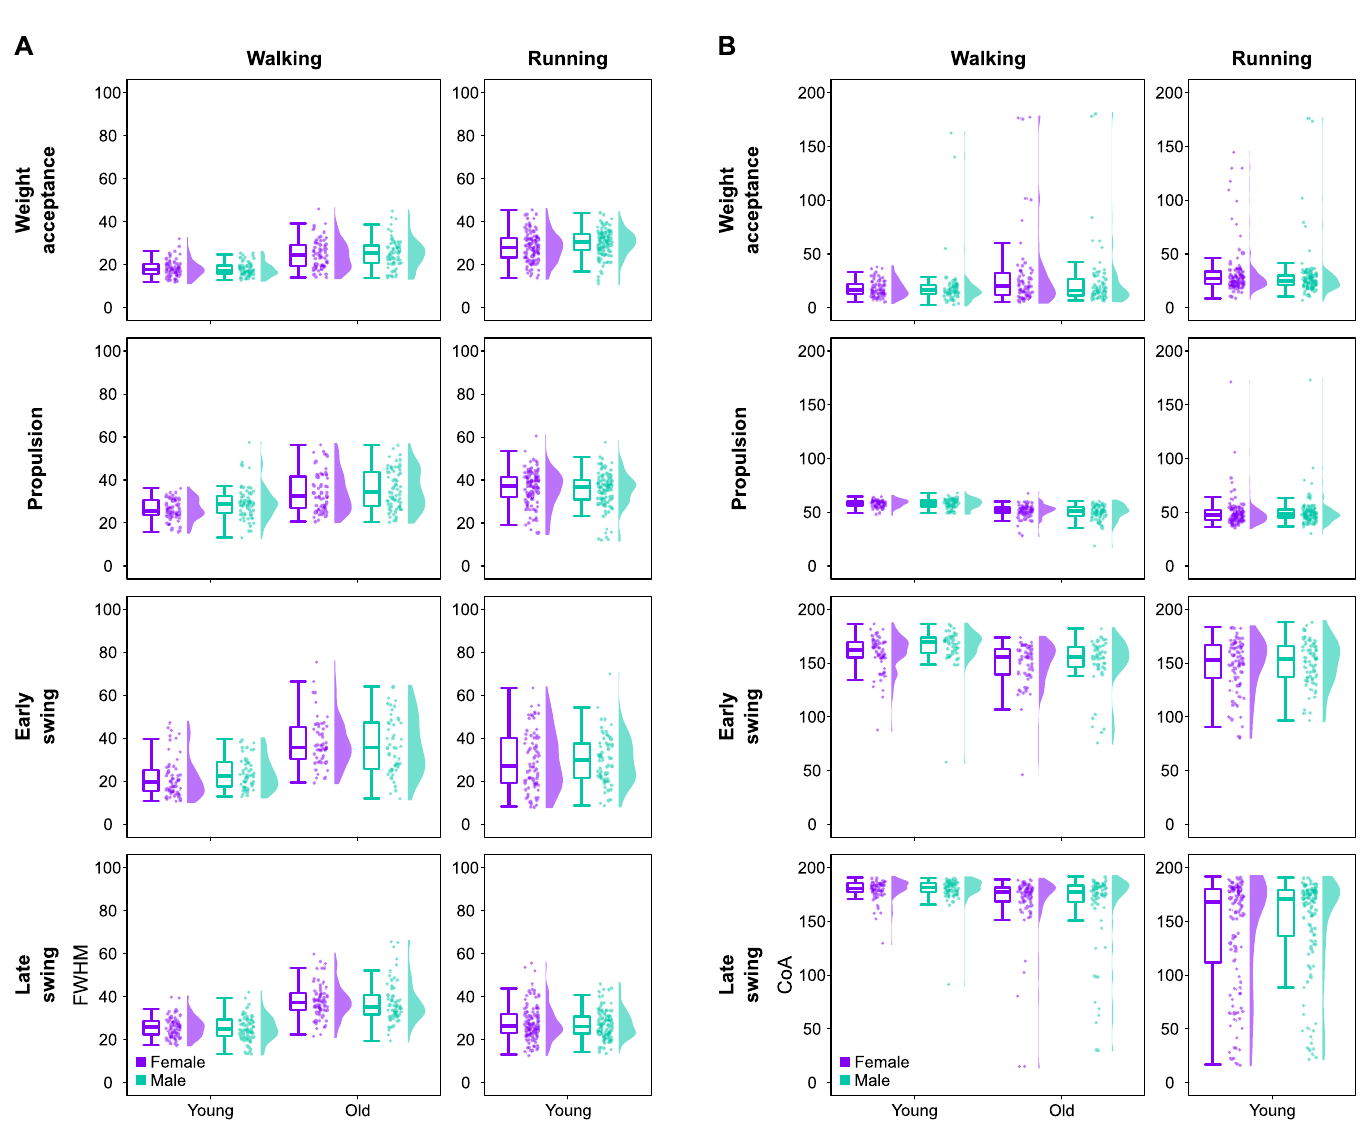
Fig 5. Full width at half maximum and center of activity of motor primitives. (A) Boxplots describing the full width at half maximum (FWHM) of the extracted motor primitives. Raw data points (dots represent the mean value of 30 gait cycles from every participant) and their density estimates are presented to the right side of each boxplot. (B) The same as in panel (A), but for the center of activity (CoA).